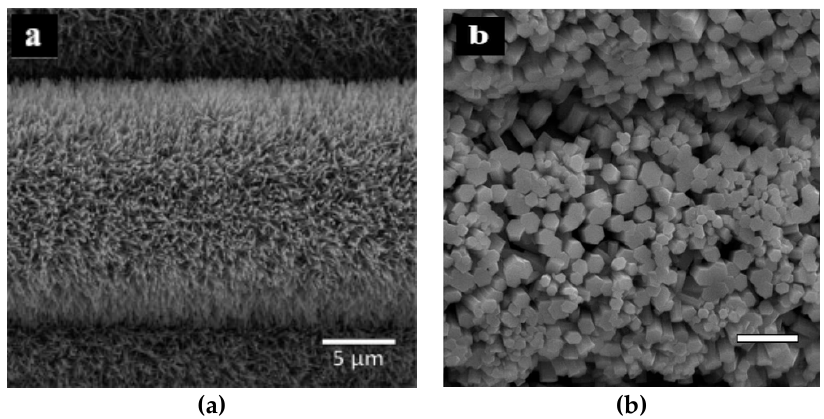
Figure 9. Zinc oxide nanowires ( a ) with high aspect ratio [100] and ( b ) with low aspect ratio (scale bar 3 µm) [112] that have been hydrothermally grown on to a PPTA fiber surface. Reprinted with permission from ref 100 and ref 112. Copyright 2015 Elsevier.